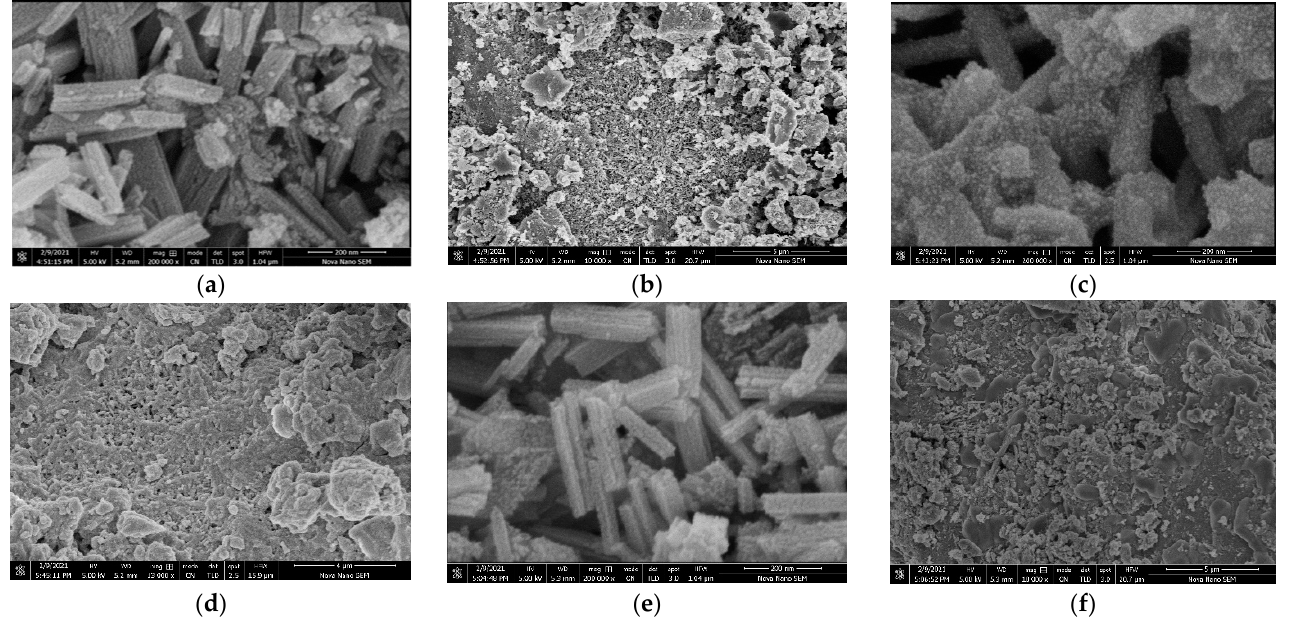
Figure 5. SEM images of prepared nano-catalysts of ISnO at different magnification. ( a ) SEM image of pure ISnO taken at 200 nm, ( b ) SEM image pure ISnO taken at 5 µm, ( c ) SEM image taken acidic ISnO at 200 nm, ( d ) SEM image of acidic ISnO taken at 5 µm, ( e ) SEM image of basic ISnO taken at 200 nm and ( f ) SEM image of basic ISnO taken at 5 µm.